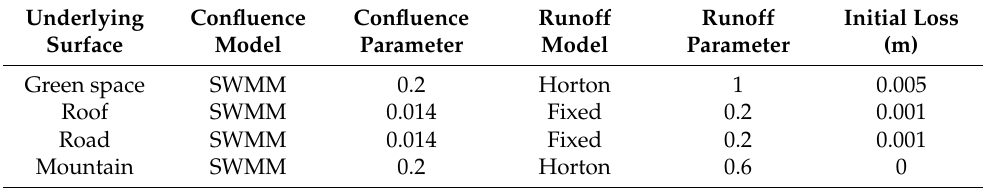
Table 1. Hydraulic parameter derived from the calibration